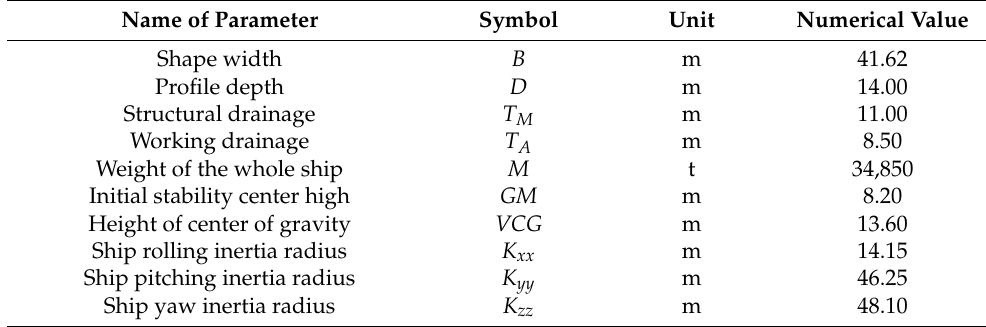
Table A3. Basic dimension parameters of pipe-laying